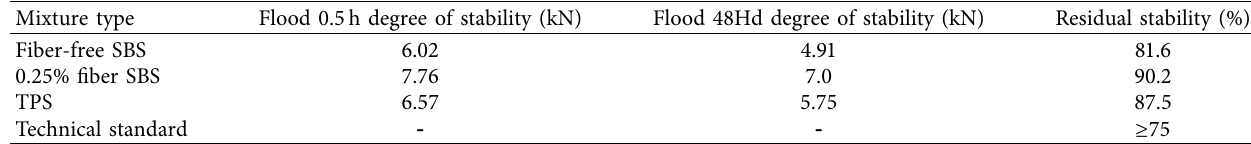
Table 13: Results of immersion Marshall test.